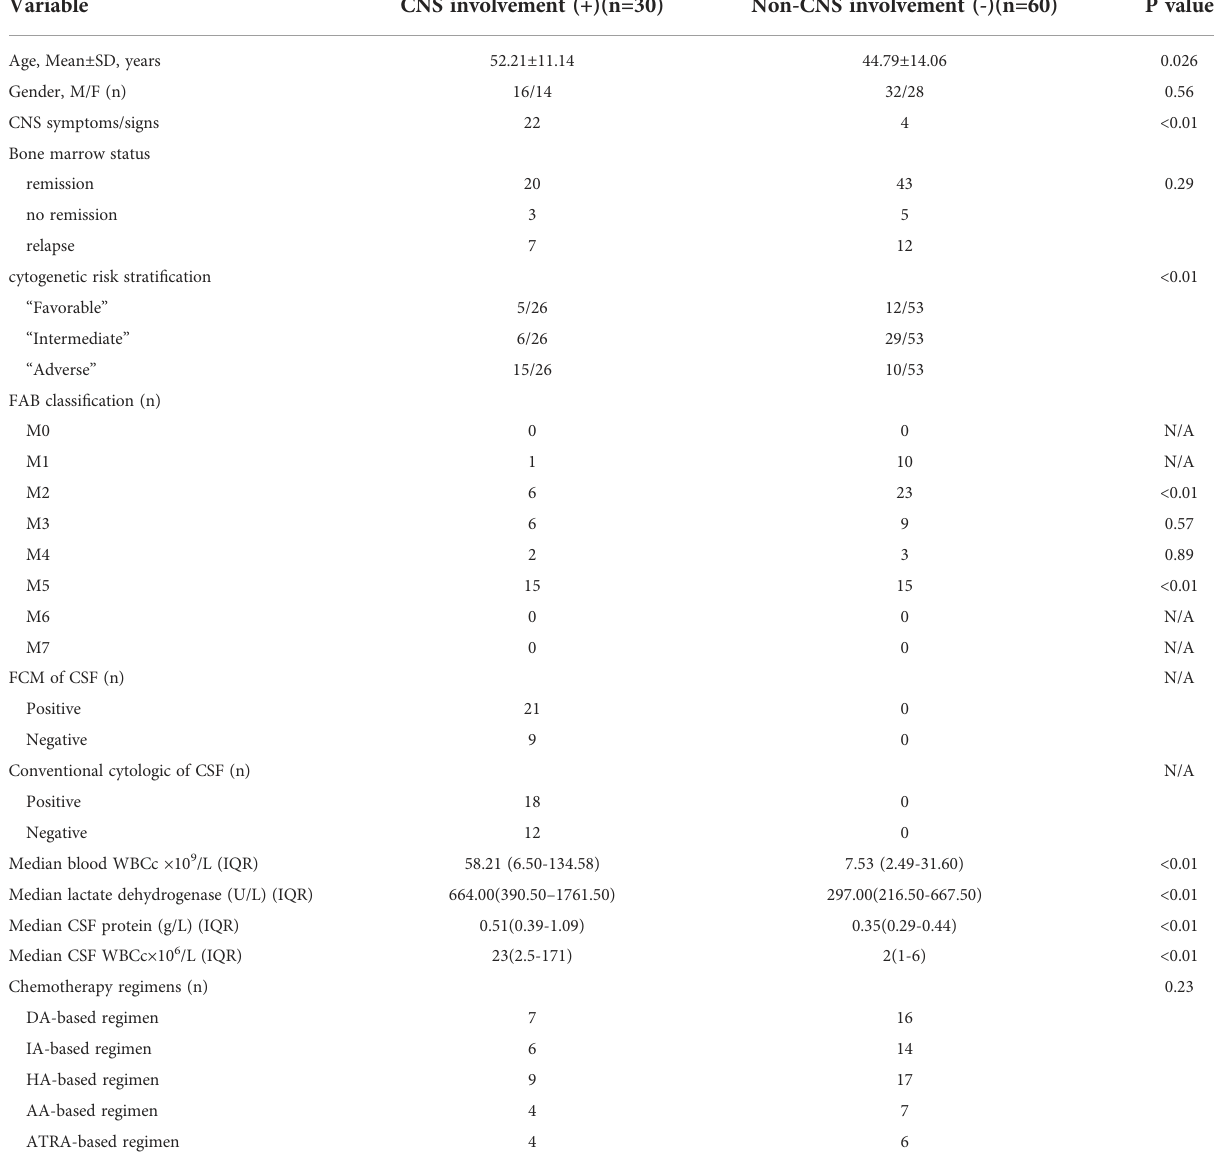
TABLE 1 General characteristic of